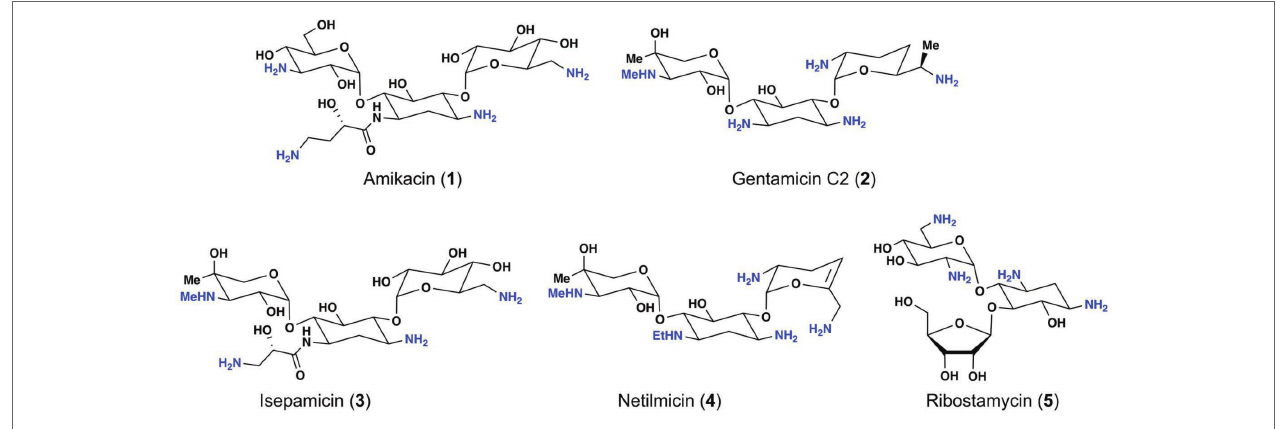
FIGURE 1 | Structures of selected aminoglycoside